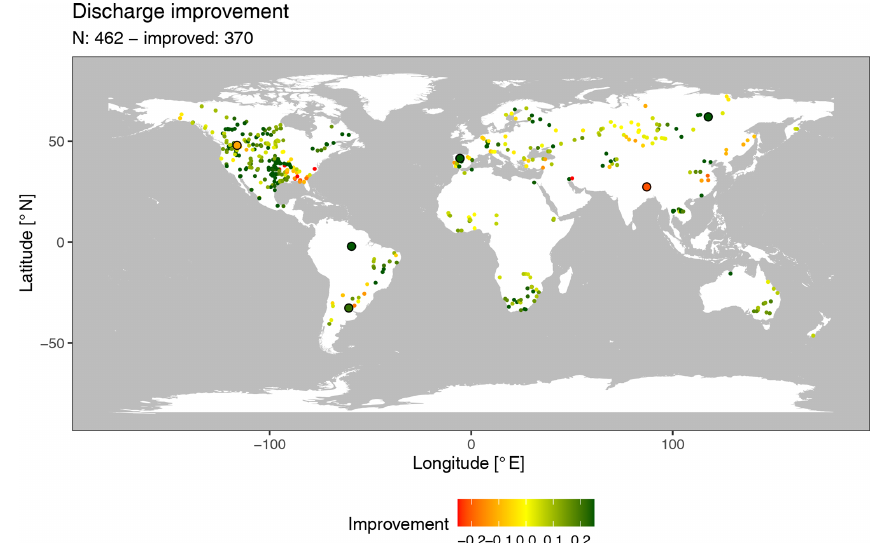
Figure 6. Discharge improvement from naturalized to anthropogenically impacted simulations (as a fraction of the naturalized RMSE). Circled larger stations are shown in Fig. 7.